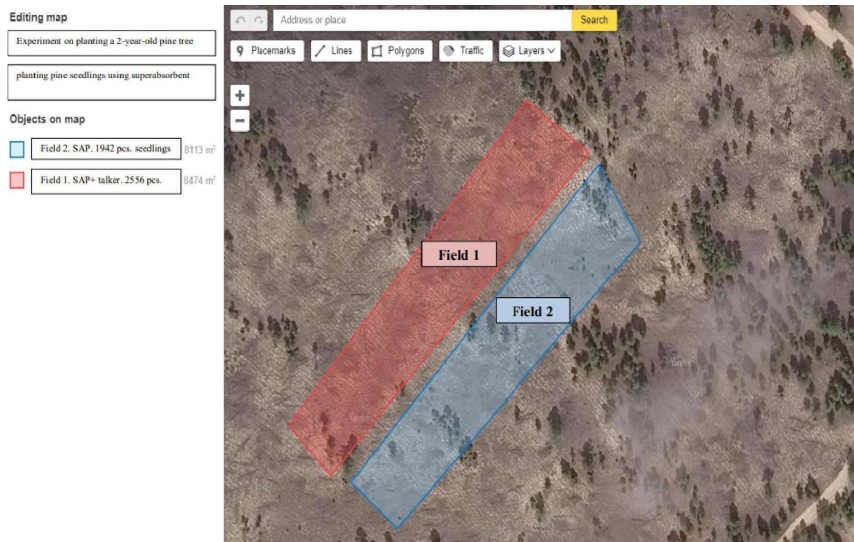
Figure 2: Google map location of trial plots 1 and 2.